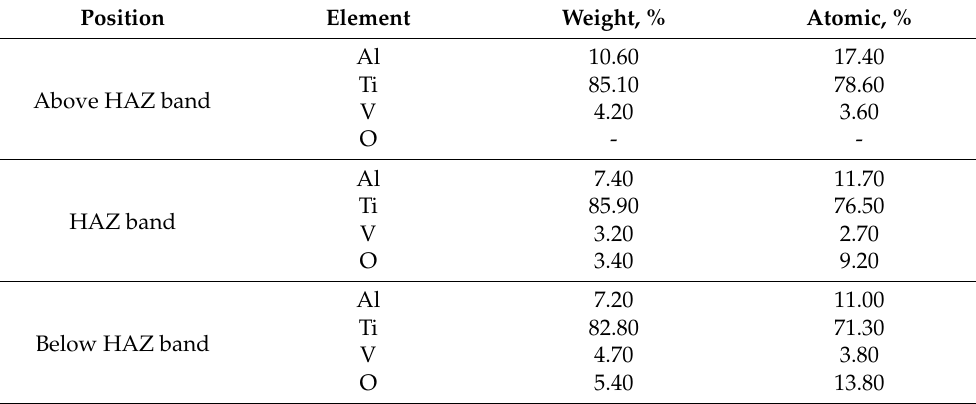
Table 4. The element composition near the HAZ band by